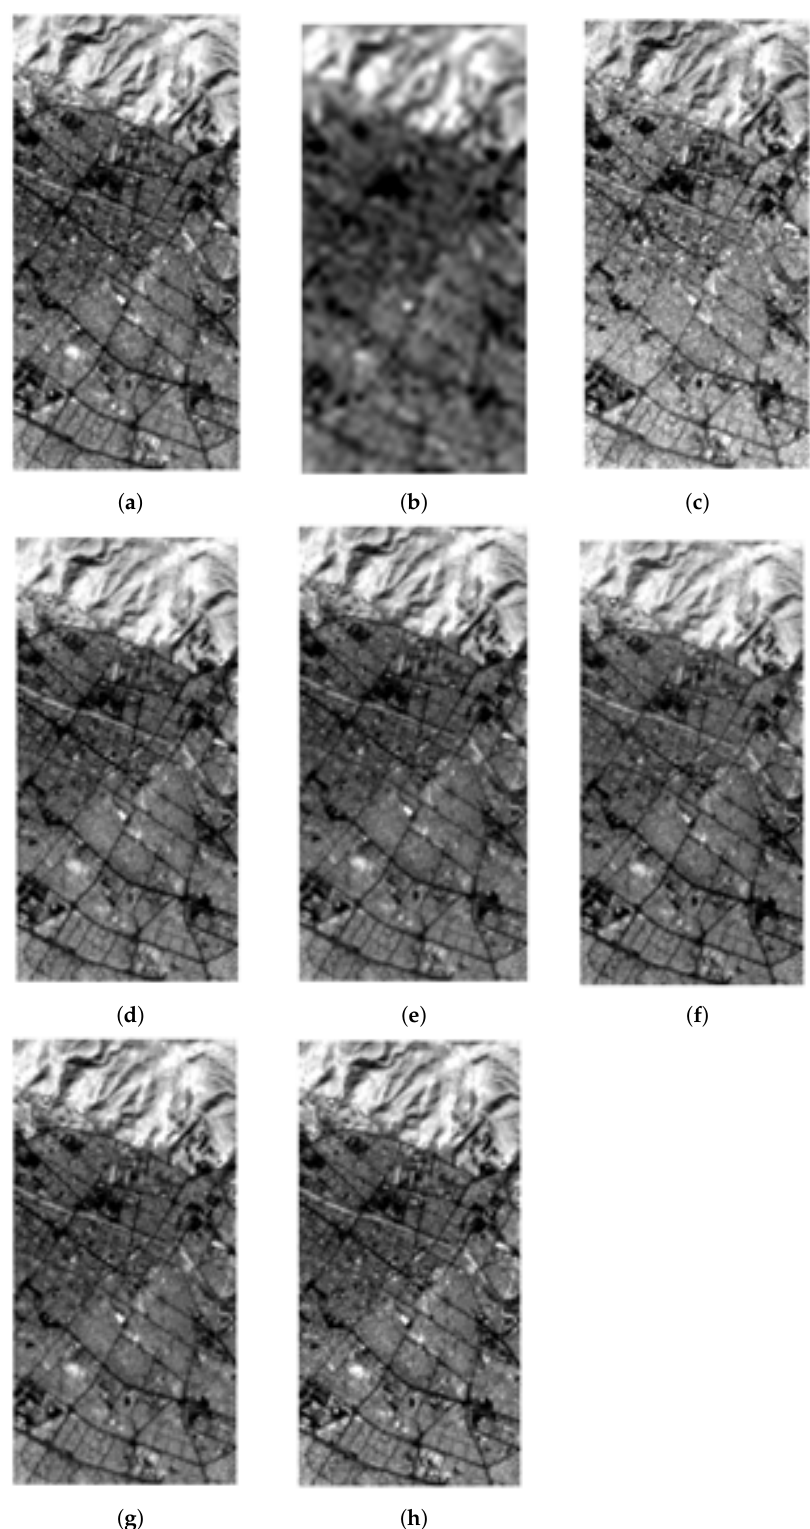
Figure 9. ( a ) Band 170 of the Shiraz ground truth image (256 × 128); ( b ) band 170 of the LRHSI; ( c ) band 2 of the MSI. Spatial resolution enhancement results of band 170 of the HSI: ( d ) CNMF; ( e ) BS; ( f ) SUSC; ( g ) Hysure; ( h ) proposed method